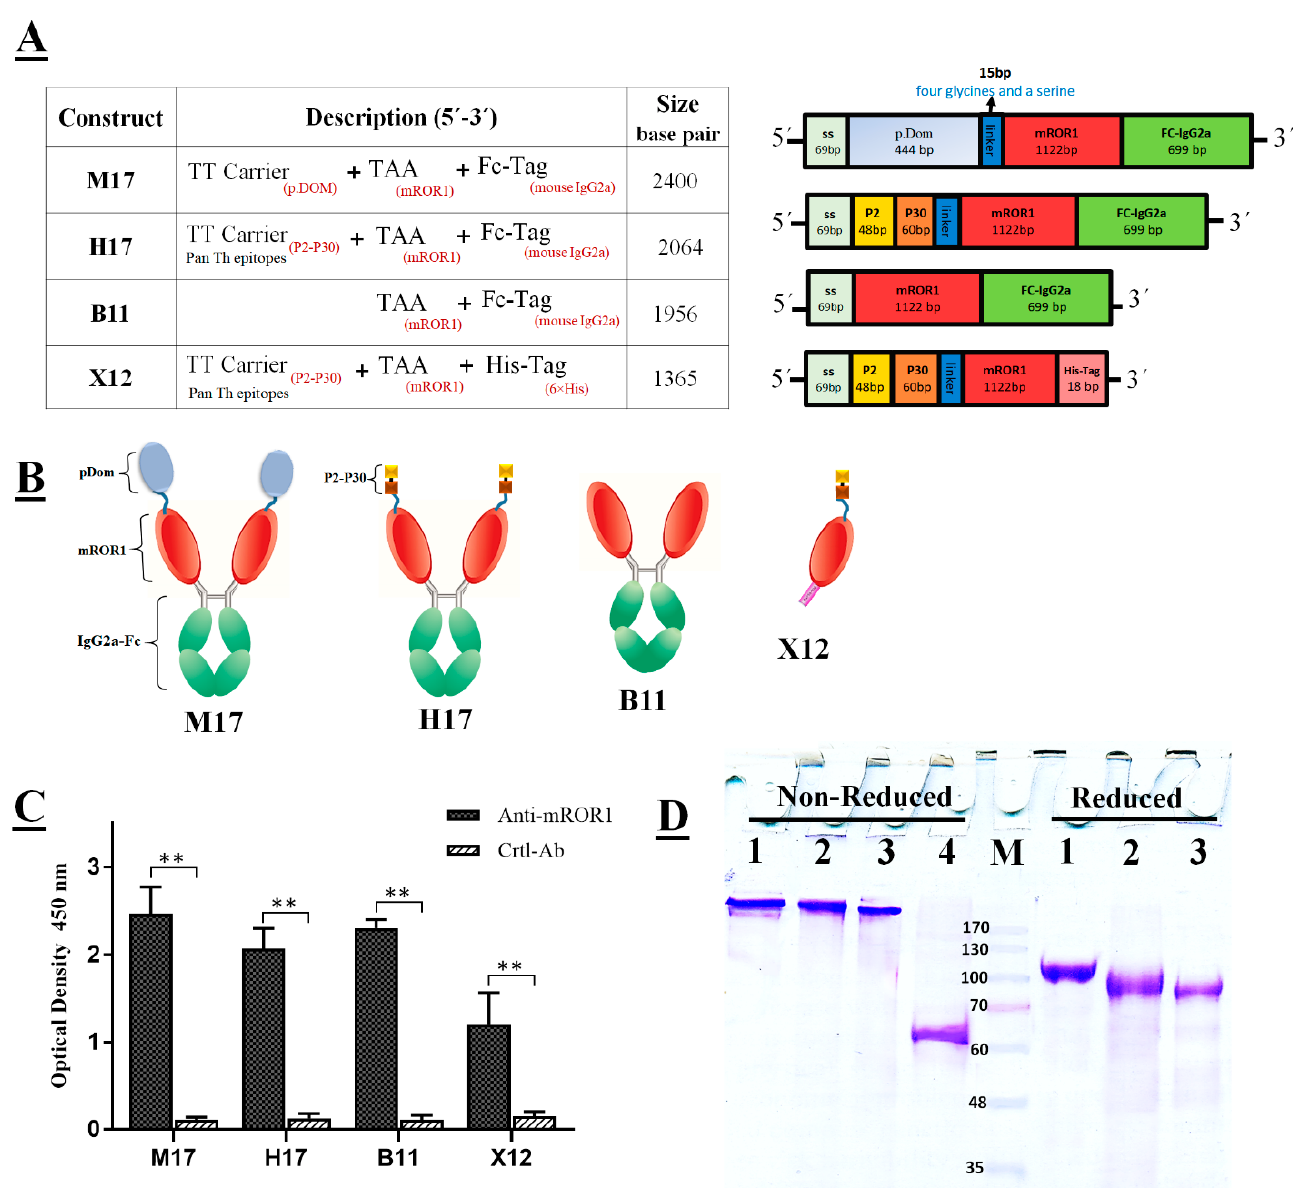
Figure 1. Design, production and characterization of ROR1 fusion proteins. ( A ) Detailed structure of expression constructs: Pan Th epitopes from tetanus toxin; p.Dom, P2, and P30 fused to mROR1 TAA with a flexible linker accompanied Fc fragment of mouse IgG2a. ( B ) Schematic illustration of the fusion proteins. ( C ) Assessment of reactivity of rabbit anti-mROR1 with each fusion protein. Normal (non-immune) rabbit serum was employed as a control. ( D ) SDS–PAGE analysis of each fusion protein under non-reducing (left panel) and reducing (right panel) conditions; M17 fusion protein (lane 1), H17 fusion protein (lane 2), B11 fusion protein (lane 3) and X12 fusion protein (lane 4). M represents molecular mass markers, with values in kilodaltons (KDa). (* p < 0.05, ** p < 0.01, and *** p < 0.001).